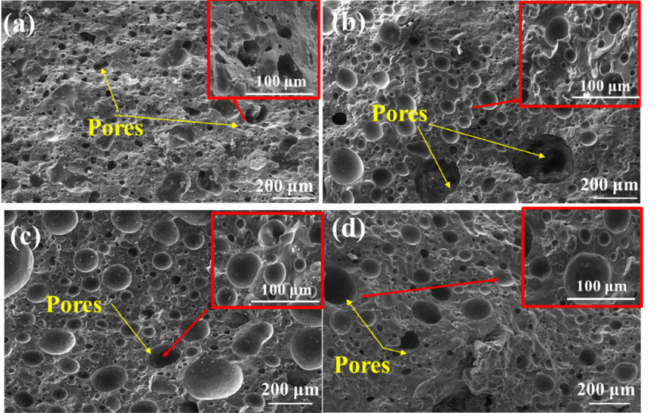
Figure 4. SEM morphologies of samples sintered at 1200 ◦ C with different CG contents: ( a ) 0%; ( b ) 8%; ( c ) 12%; and ( d )